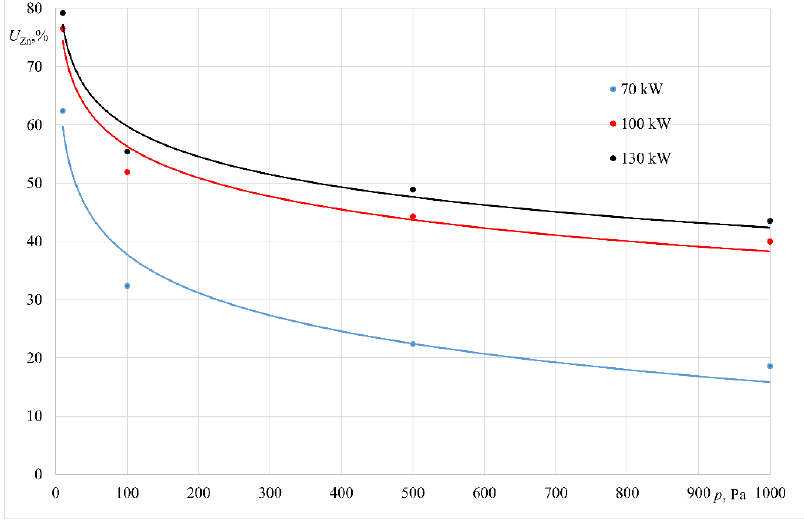
Figure 6. Relative zinc mass loss for the experiments performed in the furnace with a cold crucible.